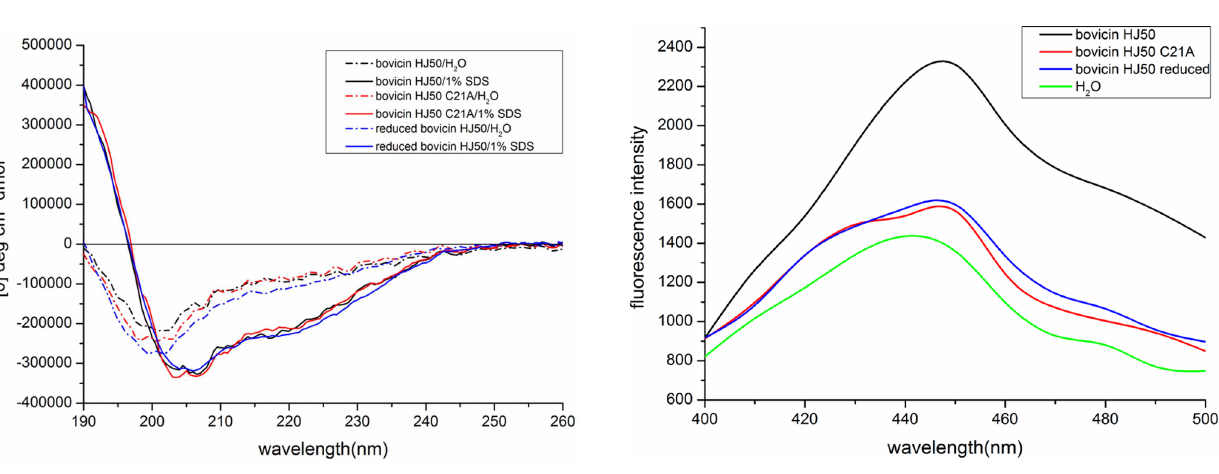
Figure 7. Circular dichroism (CD) analysis of bovicin HJ50 and its mutants. Dash-dot-dash line represented the secondary structures of bovicin HJ50 (black), its mutant C21A (red) and reduced form in H 2 O, while solid line represented the secondary their structures in 1% SDS.